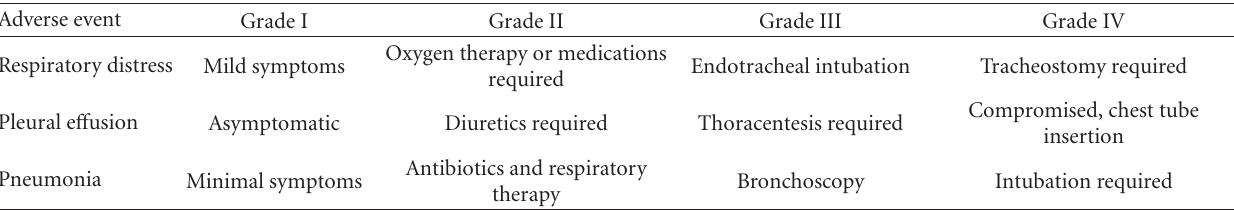
Table 1: Classification of pulmonary adverse event by